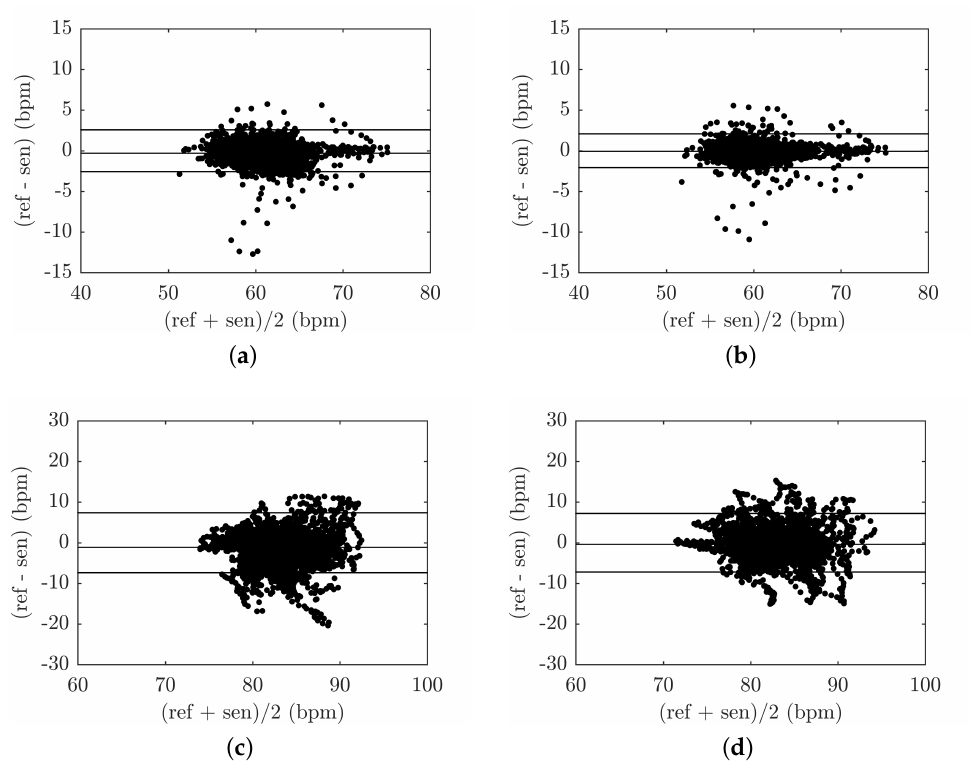
Figure 16. ( a ) B–A plot of M1 subject—FBG probe vs. ECG; ( b ) B–A plot of M1 subject—FOI probe vs. ECG; ( c ) B–A plot of F1 subject—FBG probe vs. ECG; ( d ) B–A plot of F1 subject—FOI probe vs.